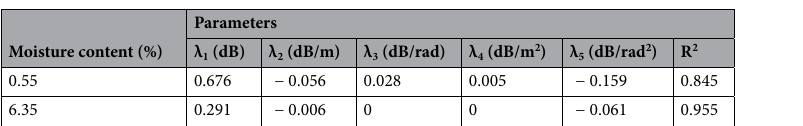
Table 3. Parameters and their evaluation of the curved surface fitting models of the composite relationships among the laser reflection intensity and incidence angle as well as distance at the two moisture contents.